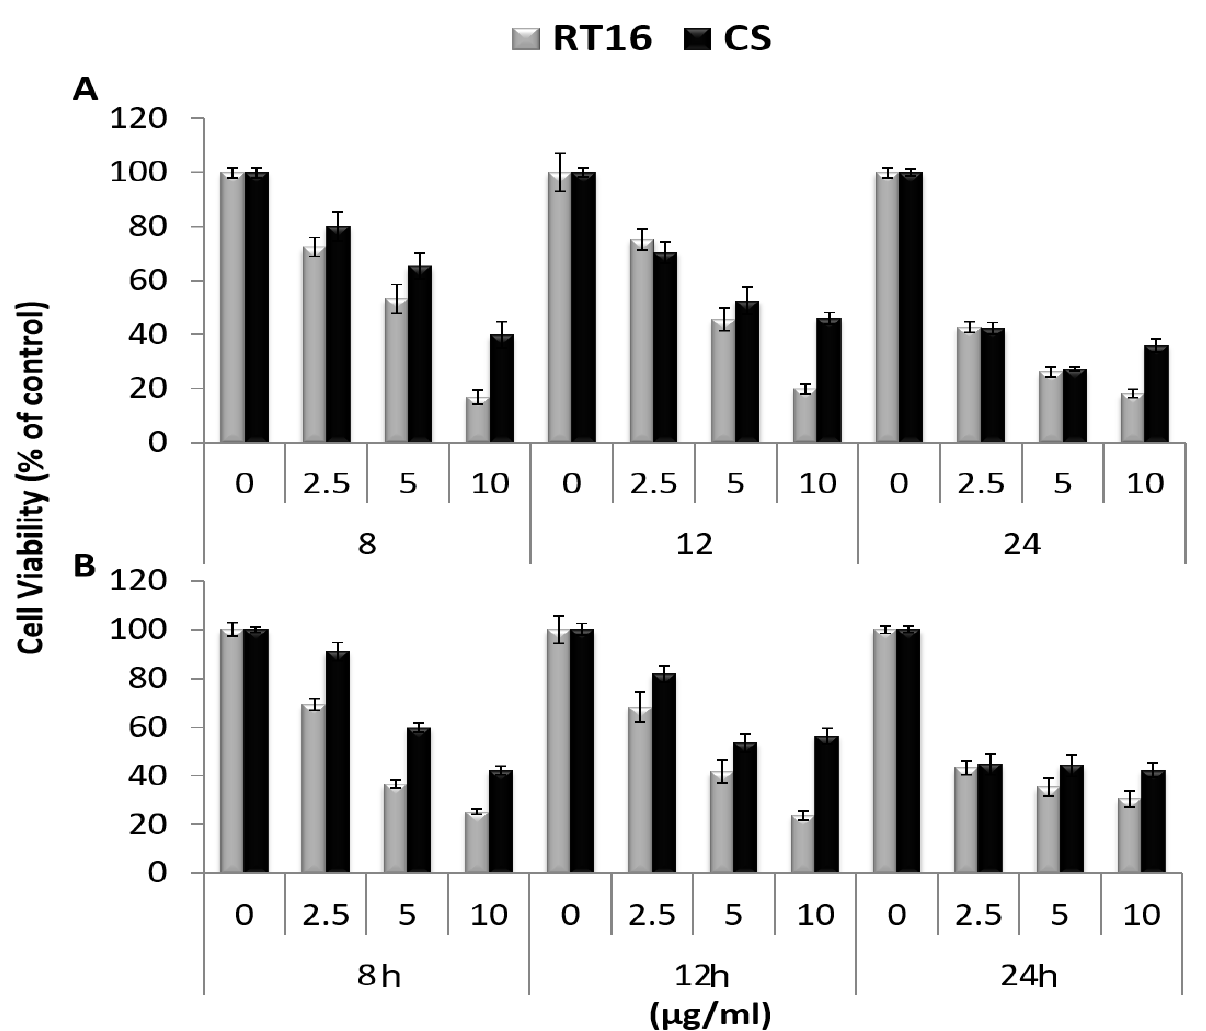
Figure 3. The effect of RT16 and CS extract on cell viability of HPAF-II ( A ) and PL45 ( B ) cells origi- nated from human pancreatic cancer. Cells were seeded in a 96-well plate (10 4 cells/mL) for 24 h, then treated with RT16 or CS extract (2.5–10 μ g/mL), and incubated for 8, 12, or 24 h. Cell viability was measured using an XTT assay. The data presented are average of at least three independent experiments—3–5 repeats each (means ± SEM) and are expressed as percentage of the respective vehicle-treated control. Statistical significance was determined by two-way ANOVA ( p < 0.001).